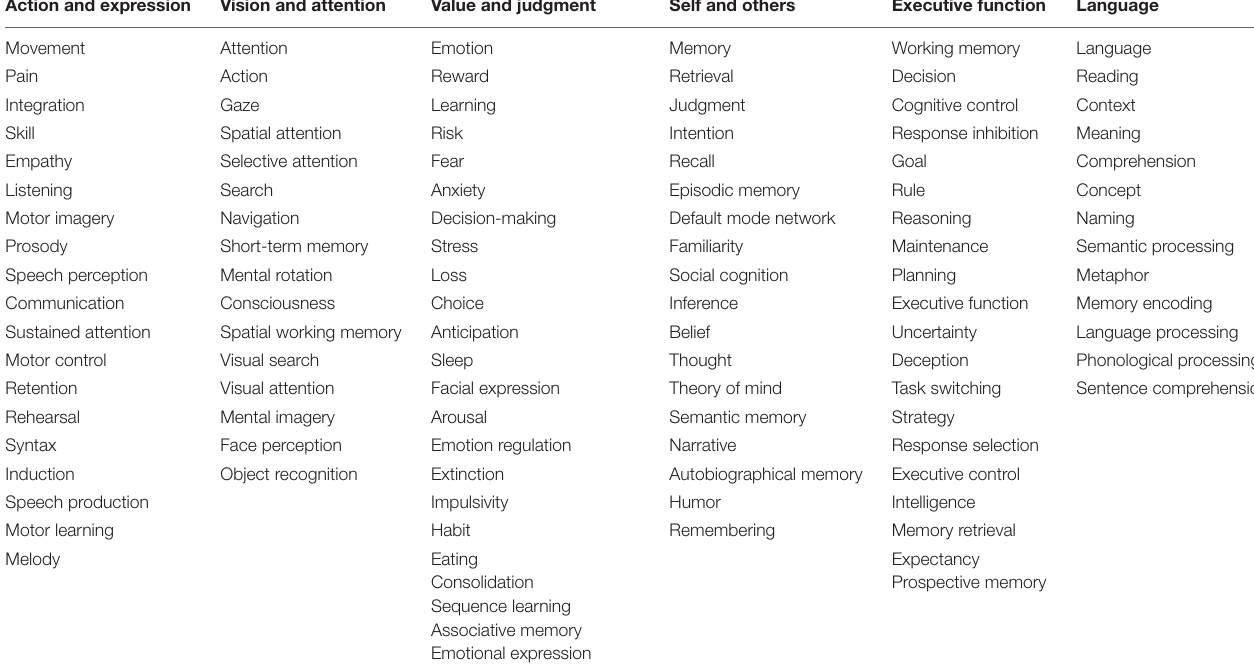
TABLE 1 | Clustering of the cognitive functions based on the CFM-to-CFM RSFC